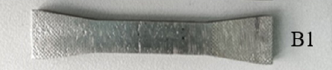
Figure 4. The SLM 316L stainless steel specimen.